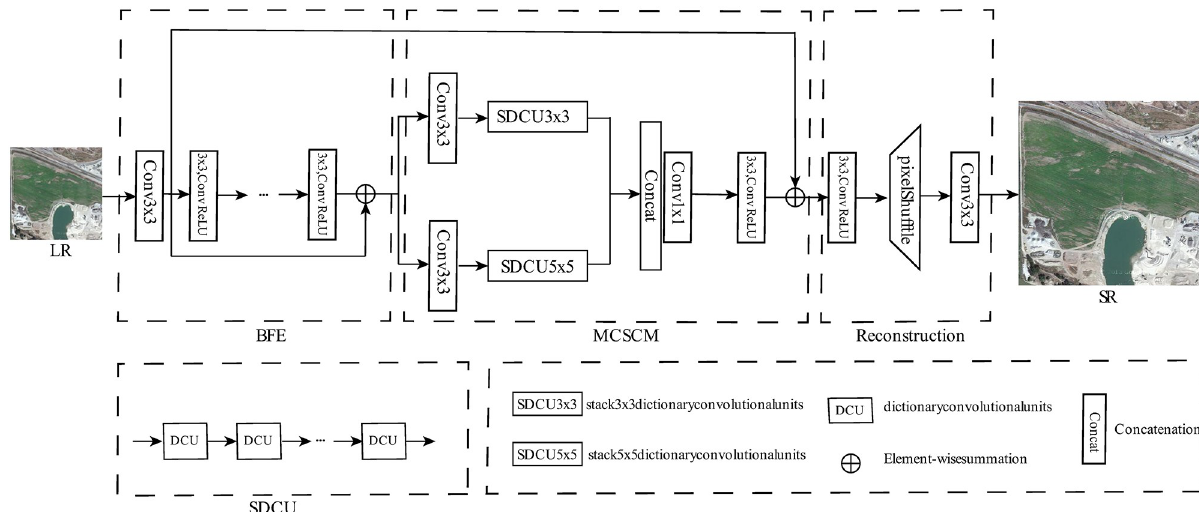
Fig 1. Architecture of the proposed MCSCN model. Our network consists of three main parts: BFE, MCSCM, and reconstruction module. We introduce a MCSCM to complement the information and make full use of the different scales of feature information.